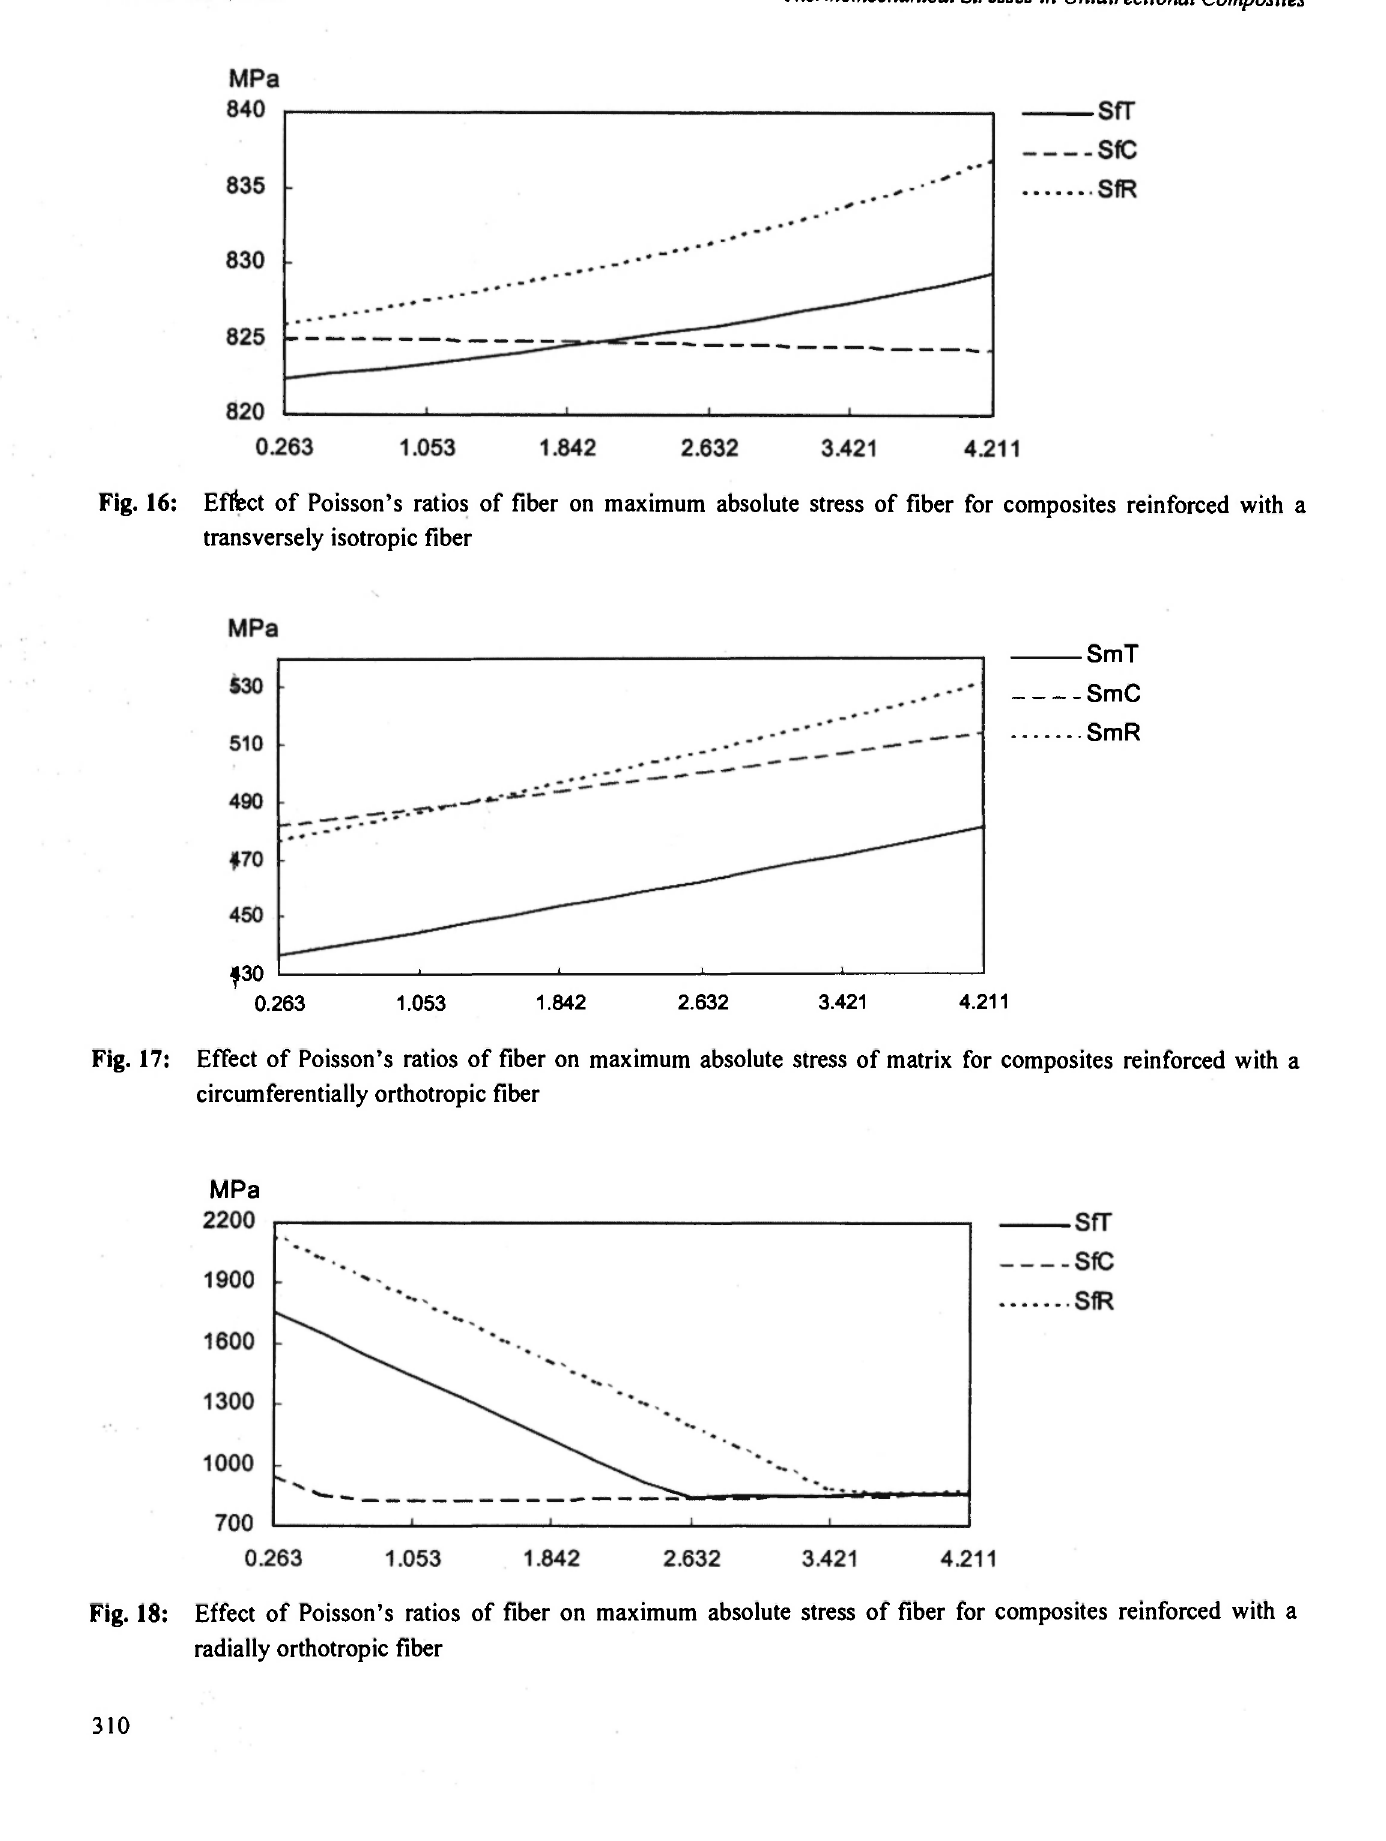
Fig. 18: Effect of Poisson's ratios of fiber on maximum absolute stress of fiber for composites reinforced with a radially orthotropic